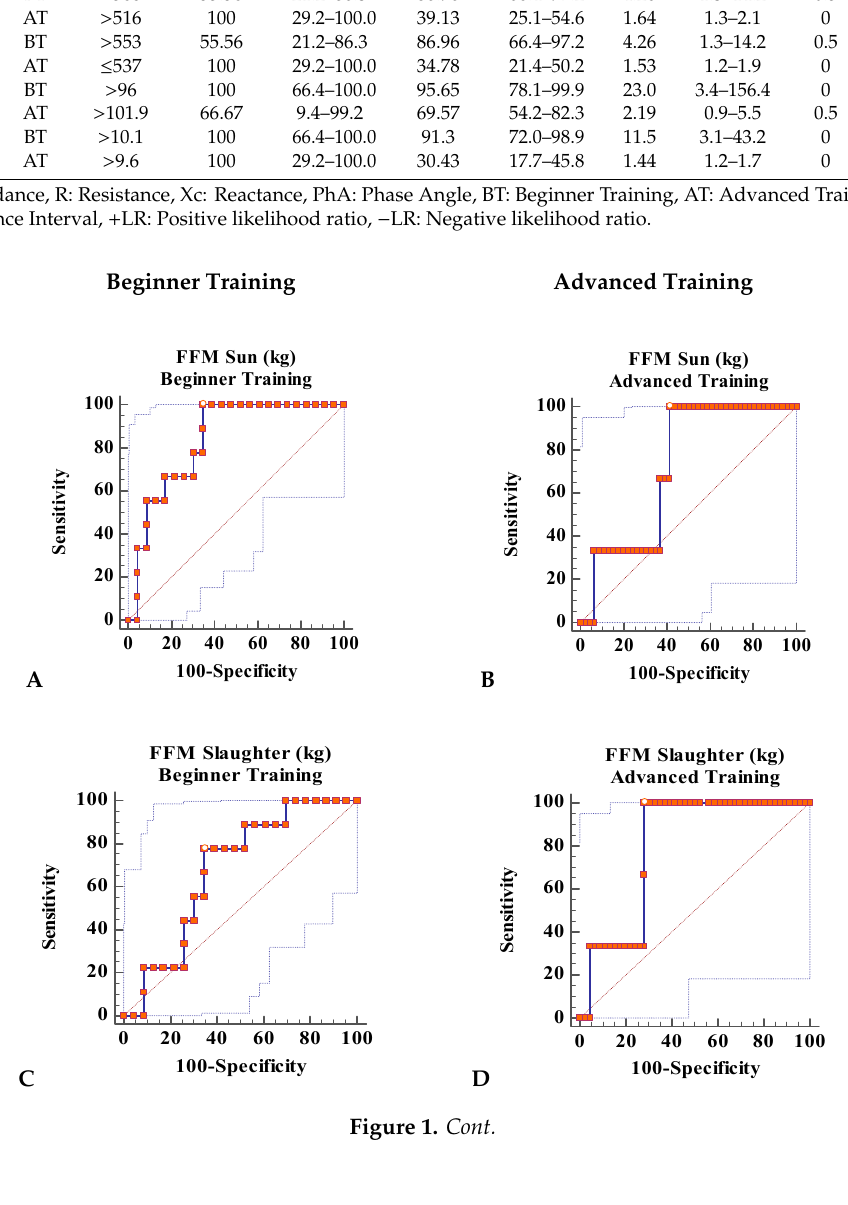
Table 7. Sensitivity and Specificity of BIA variables in Beginner and Advanced Training groups. Variable